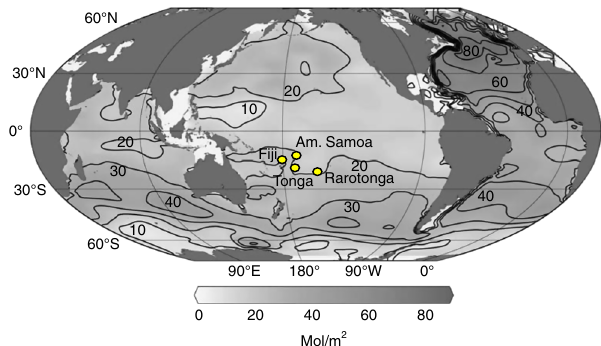
Fig. 2 Map of anthropogenic CO 2 inventory in the global ocean 59 and locations of our South Paci fi c study sites: location of our coral extension rate and skeletal δ 13 C time series from Fiji, Tonga, Rarotonga, and American Samoa in relationship to anthropogenic CO 2 water column inventory (mol m − 2 ) in the Paci fi c. Approximately 20 mol m − 2 of CO 2 has been taken up by the upper ocean at each of these study